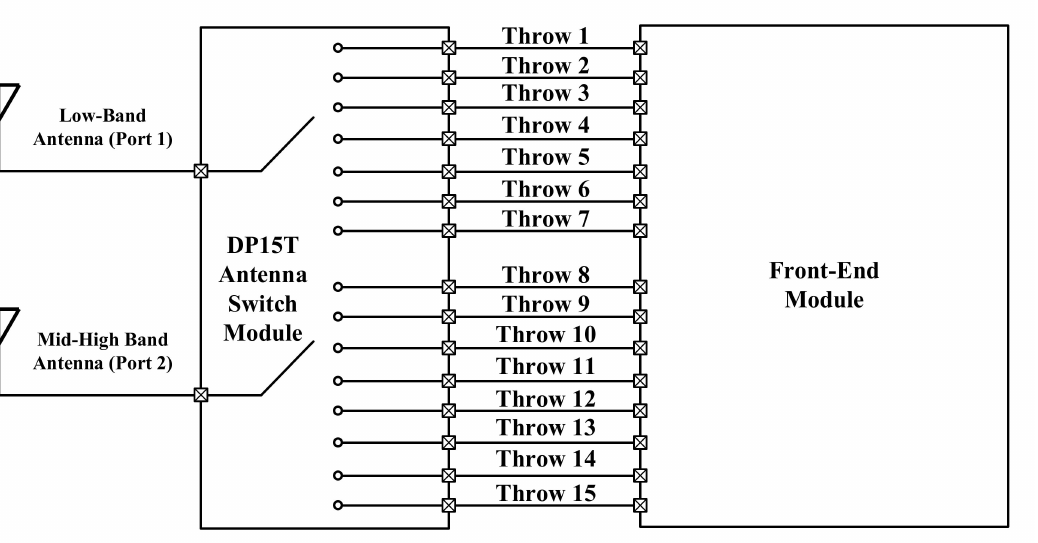
Figure 1. The proposed DP15T antenna switch module in a RF front-end application for mobile communication